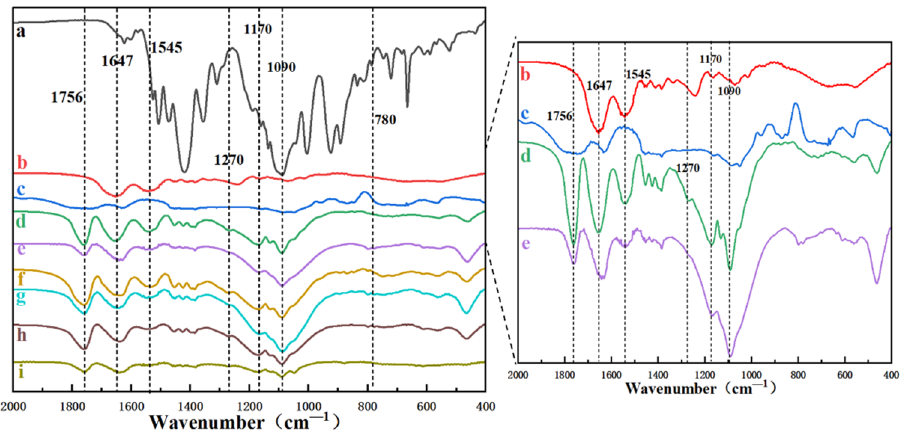
Figure 2. FTIR spectra, ( a ): ICG, ( b ): SF, ( c ): PLGA, ( d ): SF/PLGA, ( e ): SF/PLGA/20ICG, ( f ): SF/PLGA3, ( g ): SF/PLGA3/20ICG, ( h ): SF/PLGA5 and ( i ): SF/PLGA5/20ICG.